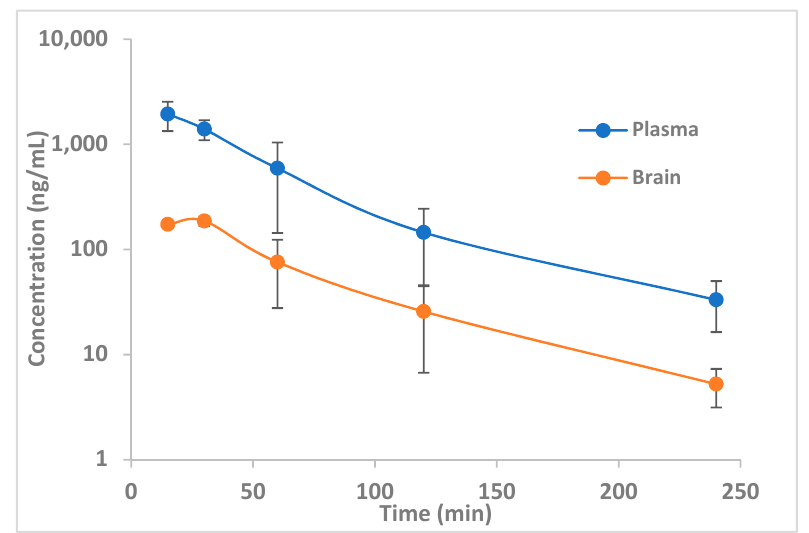
Figure 4. Pharmacokinetic study of 14b in C57/Bl6 mice. Three animals/timepoint 30 mg/kg i.p. in 1% (NMP), 0.5% Tween 80, 0.5% carboxymethyl cellulose).